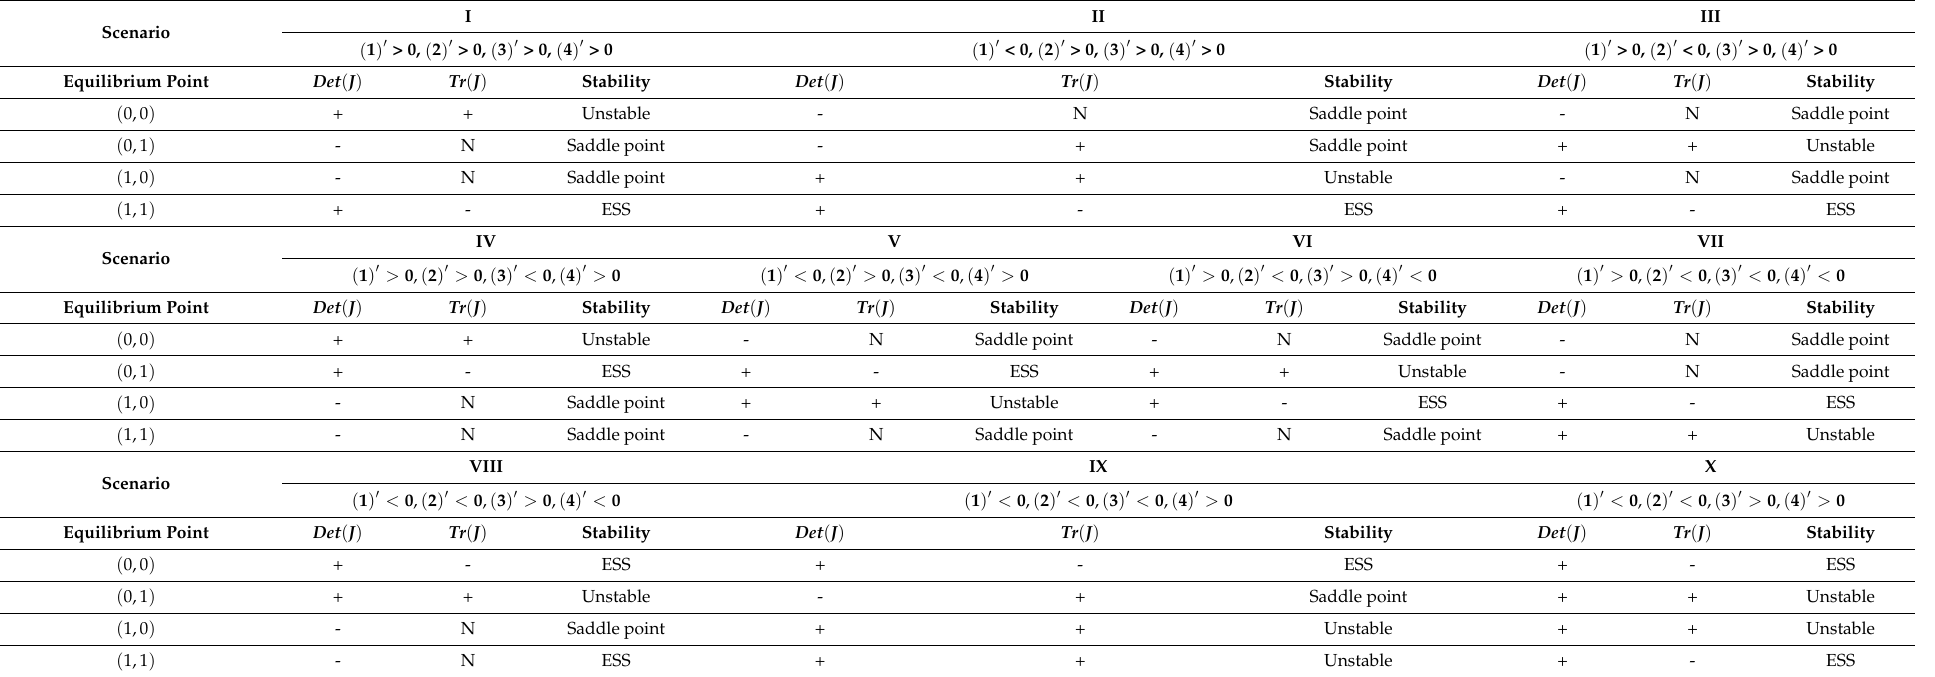
Table 7. Evolutionary equilibrium point analysis for active online lending